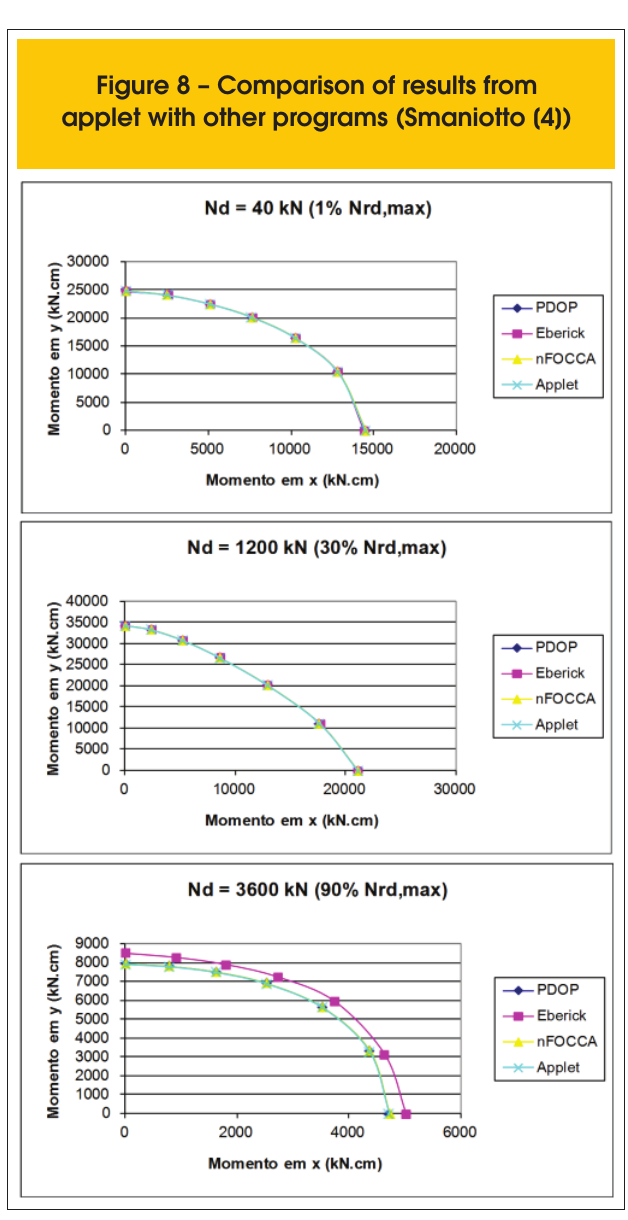
Figure 8 – Comparison of results from applet with other programs (Smaniotto